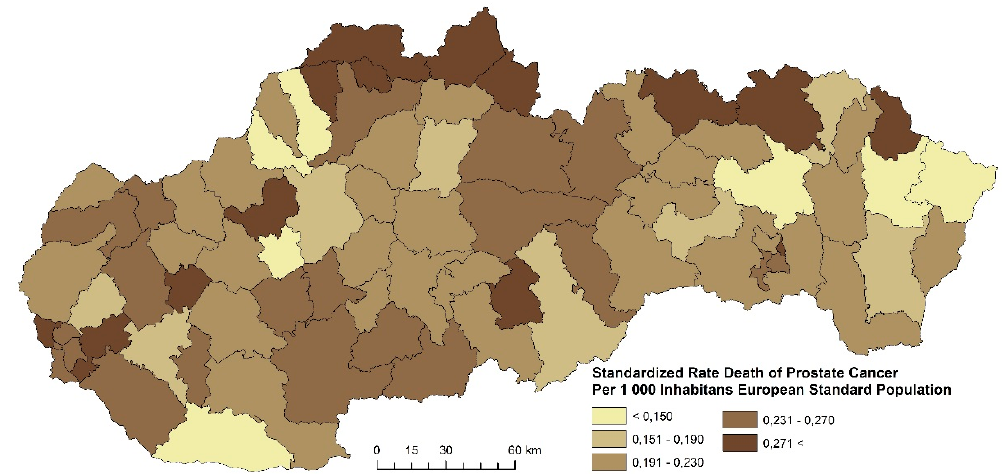
Figure 18. Standardized death rate of prostate cancer per 1000 inhabitants of European Standard Population, 2007–2012. Source: Statistical Office of the Slovak Republic, 2019.